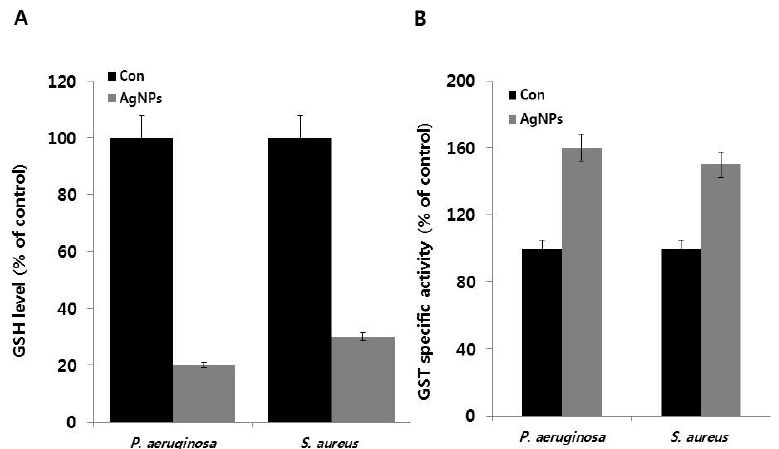
Figure 6. Effect of AgNPs on GSH and GST activity: ( A ) P. aeruginosa and S. aureus cells were treated with respective MIC of AgNPs for 12 h. GSH levels were measured enzymatically in the clear supernatant based on the reduction of 5,5 ′ -dithiobis-(2-nitrobenzoic acid) by the GSH reductase system; ( B ) GST activity was determined as described in the Materials and Methods Section. Results are expressed as the means ± SD of three separate experiments, with three replicates per experiment. Statistically significant differences between treatment and control groups were determined using student’s t -test ( p < 0.05).